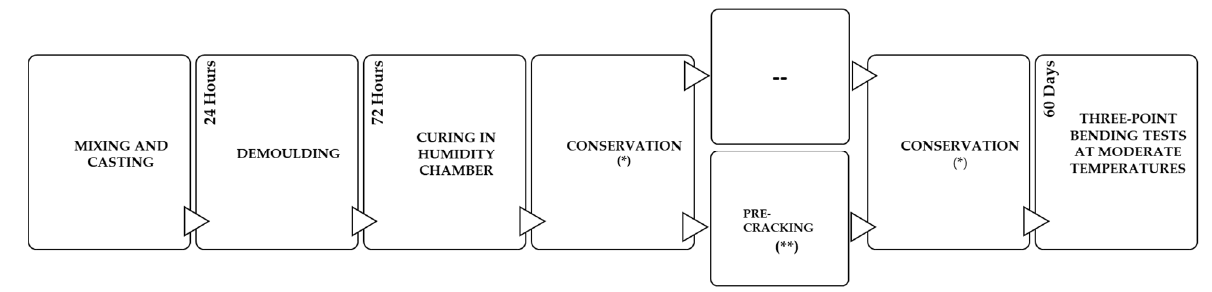
Figure 3. Summary of the procedure. (*) Conditions described in Table 3; (**) Depending on the specimens.